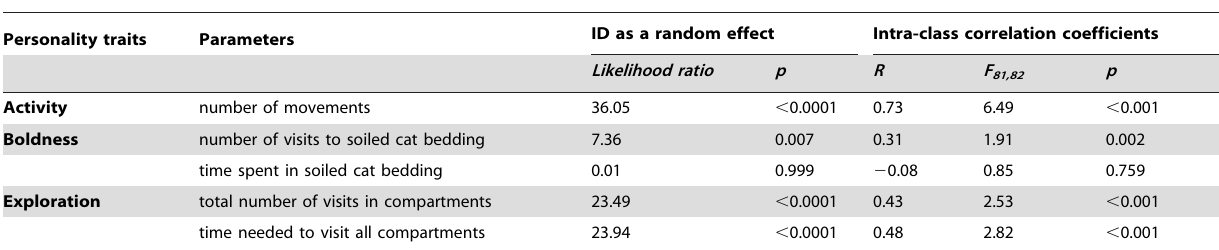
Table 1. Individual consistency of the behavioural variables assessed twice at a one-week interval, estimated firstly from mixed model analysis accounting for genetic background, body weight, sex, session, trial and interactions, and secondly from ANOVA- based intra-class correlation coefficients.